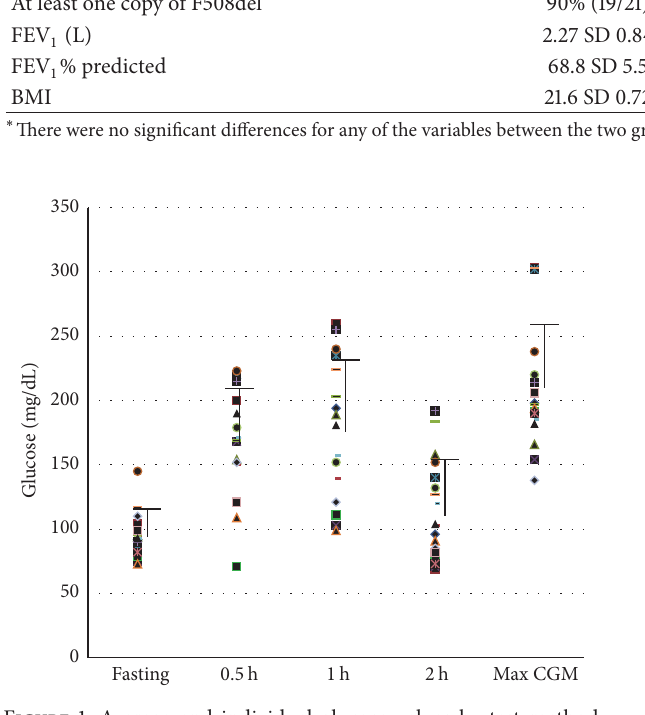
Figure 1: Average and individual glucose values by test method. IndividualsubjectglucosevaluesforinitialstudyOGTTateachtime point measured and maximum glucose value obtained by CGM are shown. Error bars represent average subject values for each OGTT time point and average maximum CGM